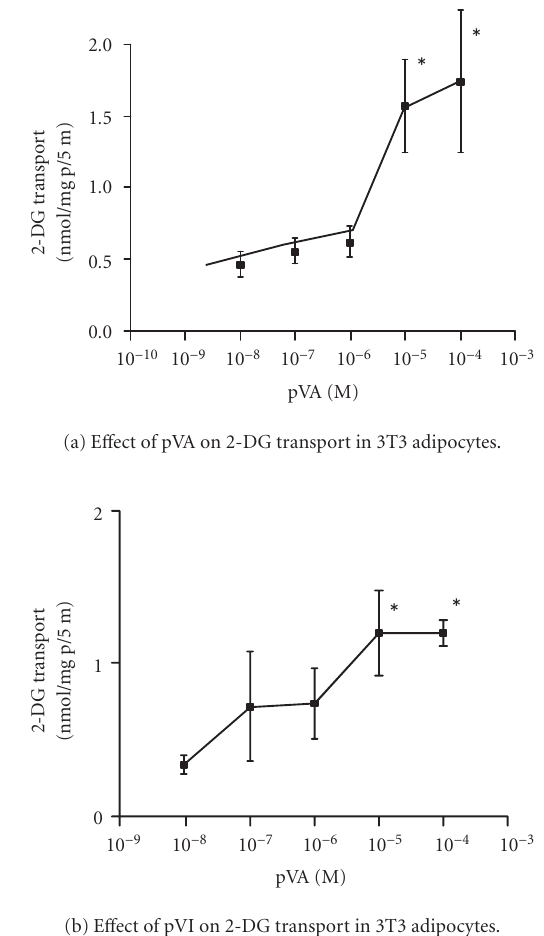
Figure 2. E ff ect of di ff erent vanadate compounds at several concentrations on basal and insulin-stimulated 2-DG transport in 3T3-L1 fibroblasts. Panel (a) pVA; ∗ P < . 05, 1-way ANOVA, F = 8 . 95, n = 9 (triplicate plates in all experiments). Panel (b) pVI; ∗ P < . 05, 1-way ANOVA, F = 4 . 99, n = 7 (triplicateplatesinallexperiments). Alldata ± SE.pVAorpVIexposuretime was for 60minutes. See Materials and Methods for additional experimental details.